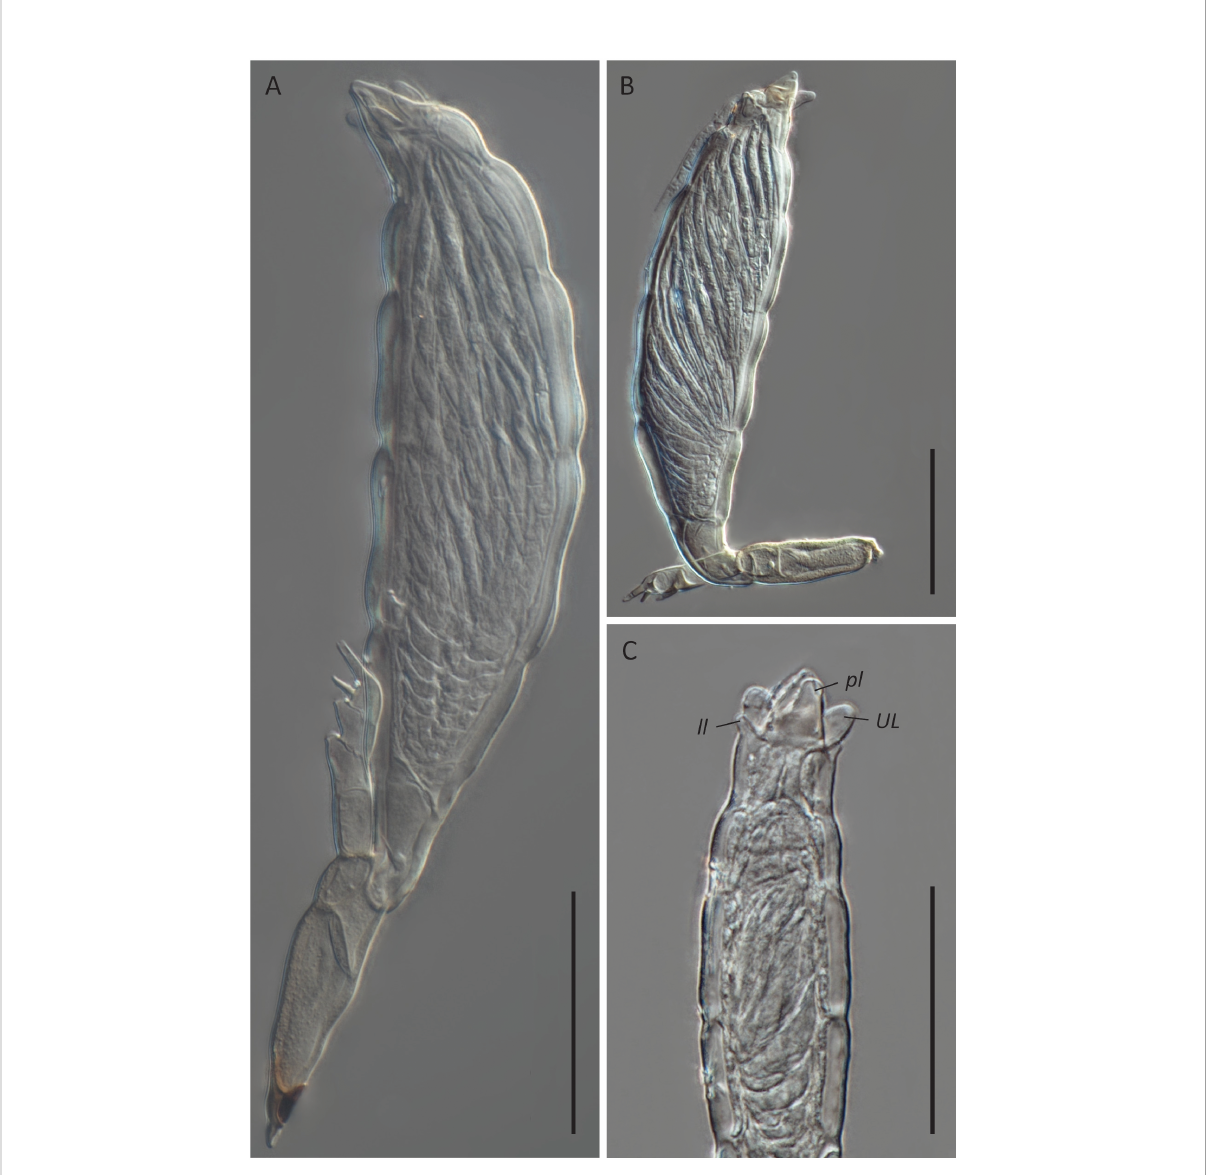
FIGURE 5 Hesperomyces sp. ex Hyperaspis vinciguerrae . (A) Mature thallus, slide D. Haelew. 3939a. (B) Mature thallus, slide D. Haelew. 3939a. Cell VI is highly bent. (C) Perithecial tip of a mature thallus, slide D. Haelew. 3939d. Indicated are the two lower lobes ( ll ), the two upper lobes ( UL ), and the two perithecial lips ( pl ), similar to Hesperomyces hyperaspidis . Scale bar 50 m